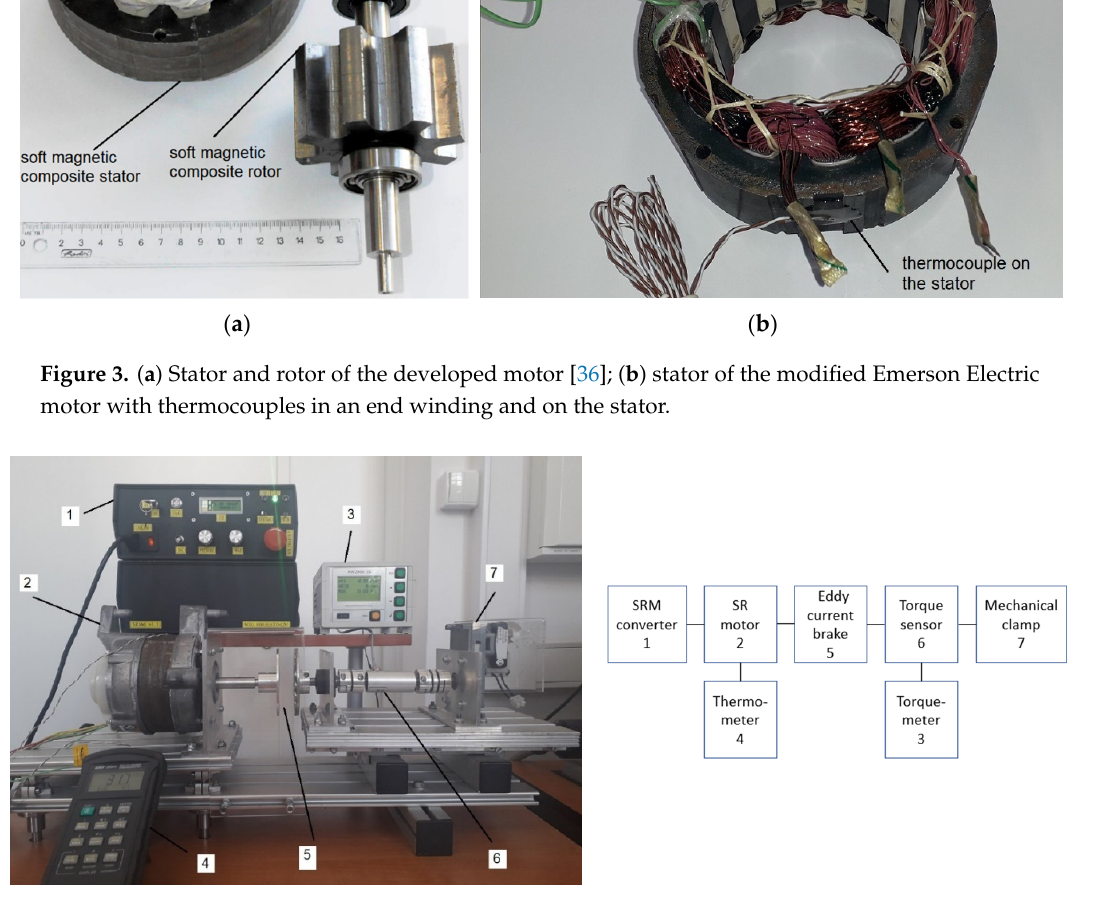
Figure 3. ( a ) Stator and rotor of the developed motor [36]; ( b ) stator of the modified Emerson Electric motor with thermocouples in an end winding and on the stator.